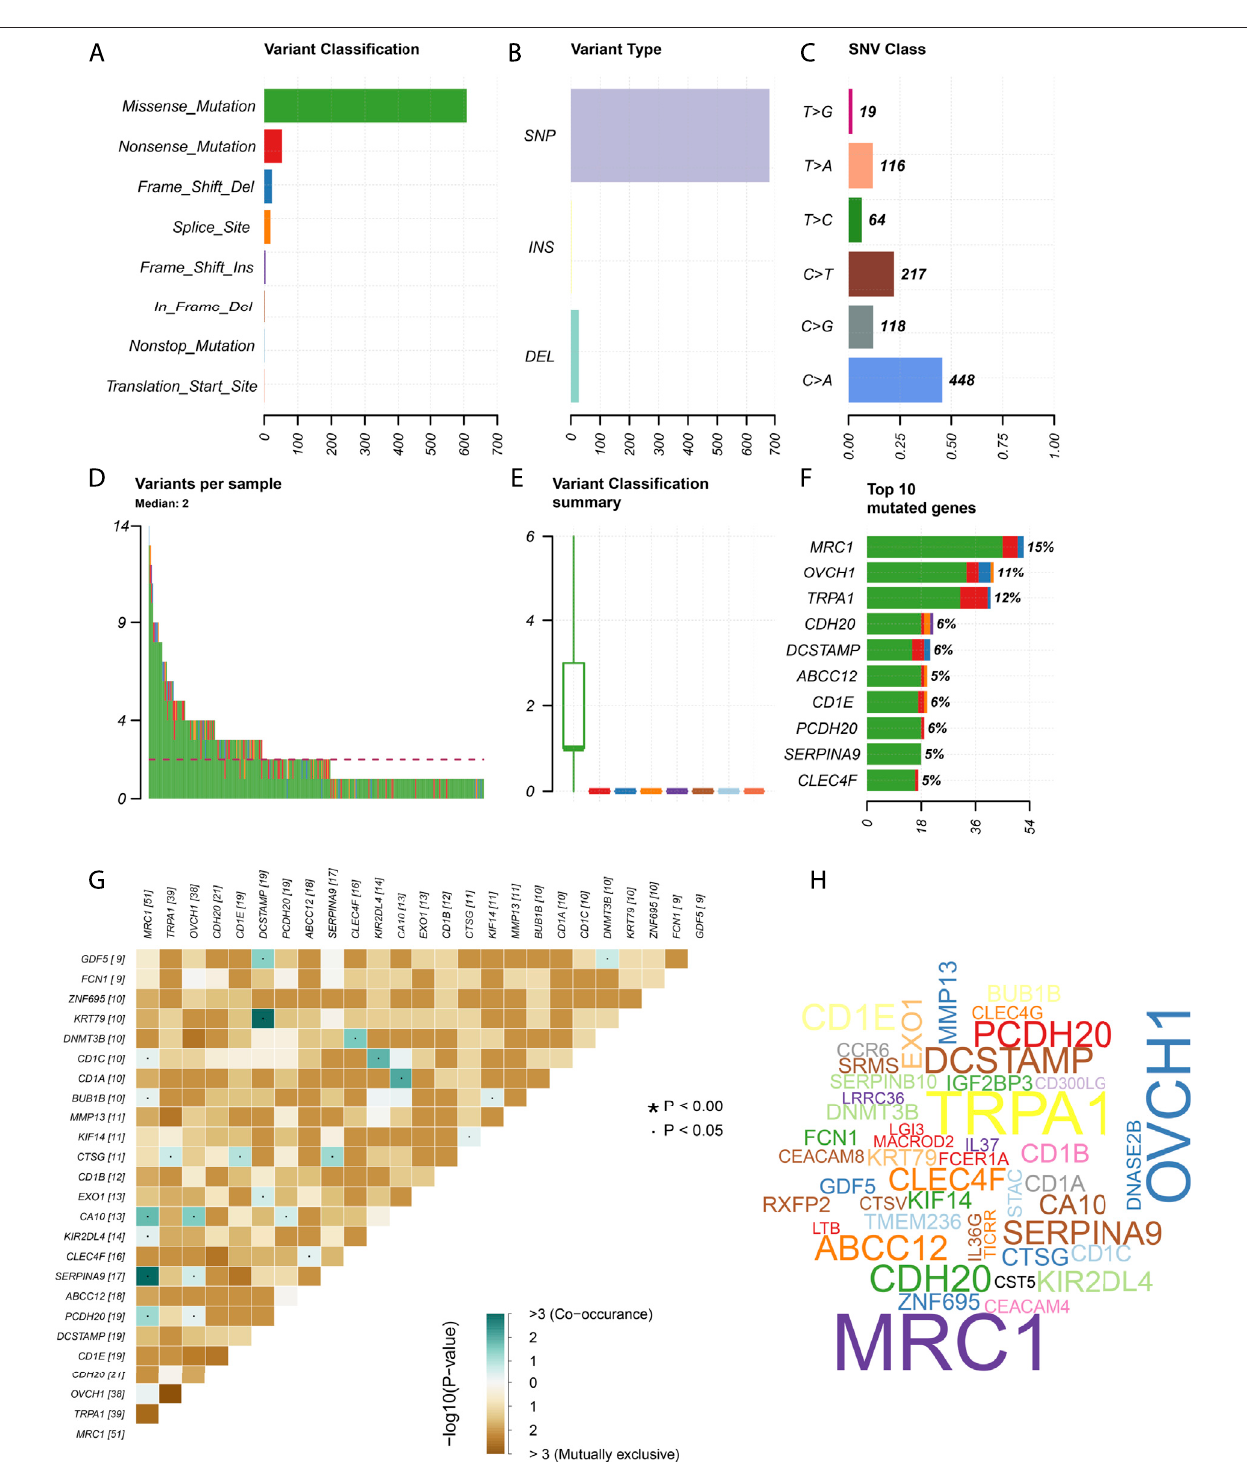
FIGURE 10 | Summary of mutation information in the CCL17-related module genes in TCGA-LUAD samples. (A-C) Variant classi fi cation (A) , variant type (B) , and SNVclass (C) . (D-E) variantsinpersampleandsummaryofvariantclassi fi cationineachsample. (F) Top10genesmutated. (G) Co-expressionanalysisbetweenmutant genes. (H) Genecloud plots show the mutation frequencies of most genes, with larger fonts representing higher mutation frequencies.